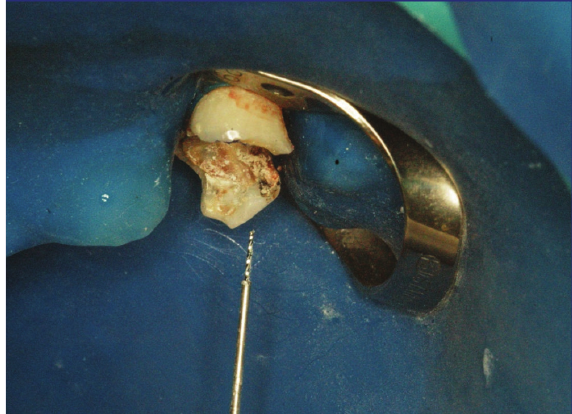
Figure 6: Periapical radiograph of the endodontic treatment com-